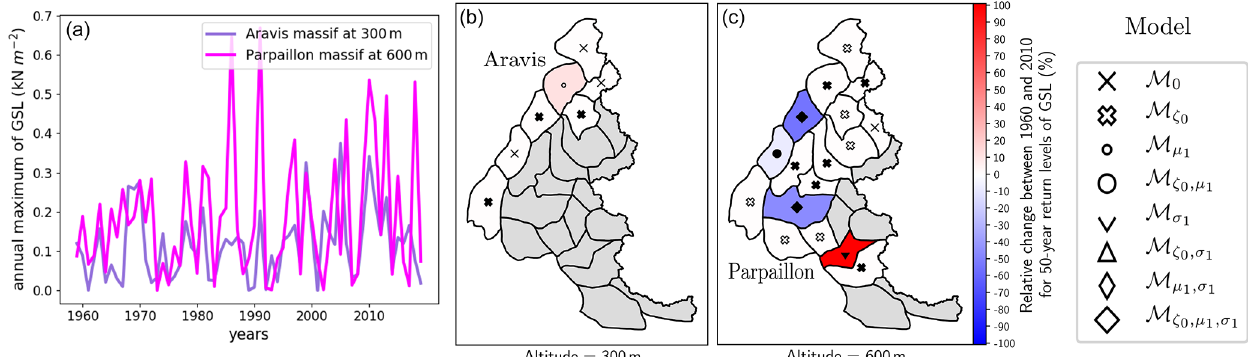
Figure 7. (a) Time series of annual maxima for ground snow load (GSL) for two massifs (Aravis and Parpaillon) either at 300m or 600m of altitude. (c) Trend for annual maxima of ground snow load (GSL) at 300 and 600m of altitude. Markers show selected model M N , while filled markers symbolize models that are significantly better than the Gumbel model M 0 (Sect. 4.2). Grey areas denote either time series that were excluded (Sect. 4.4) or missing data, e.g. when the altitude considered is above the top altitude of the massif.